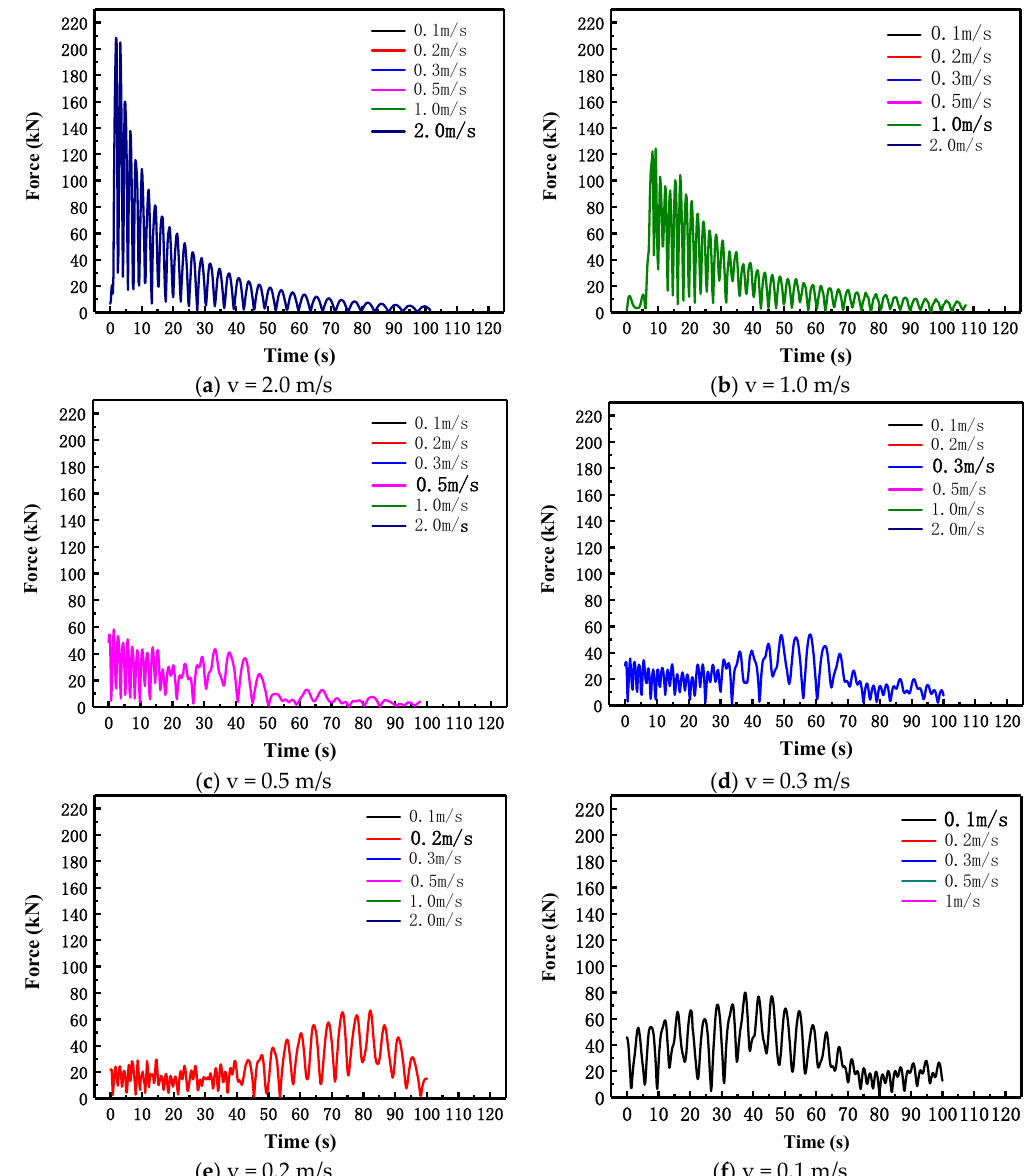
Figure 11. Different lowering speeds of the subsea tree. Figure 11. Di ff erent lowering speeds of the subsea